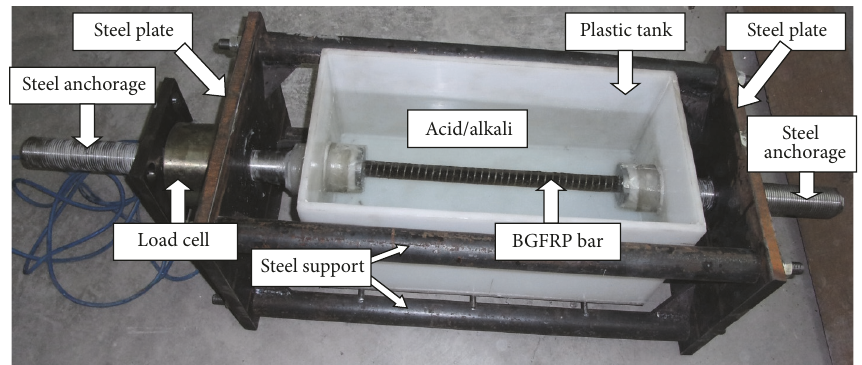
Figure 3: Photo of test apparatus.